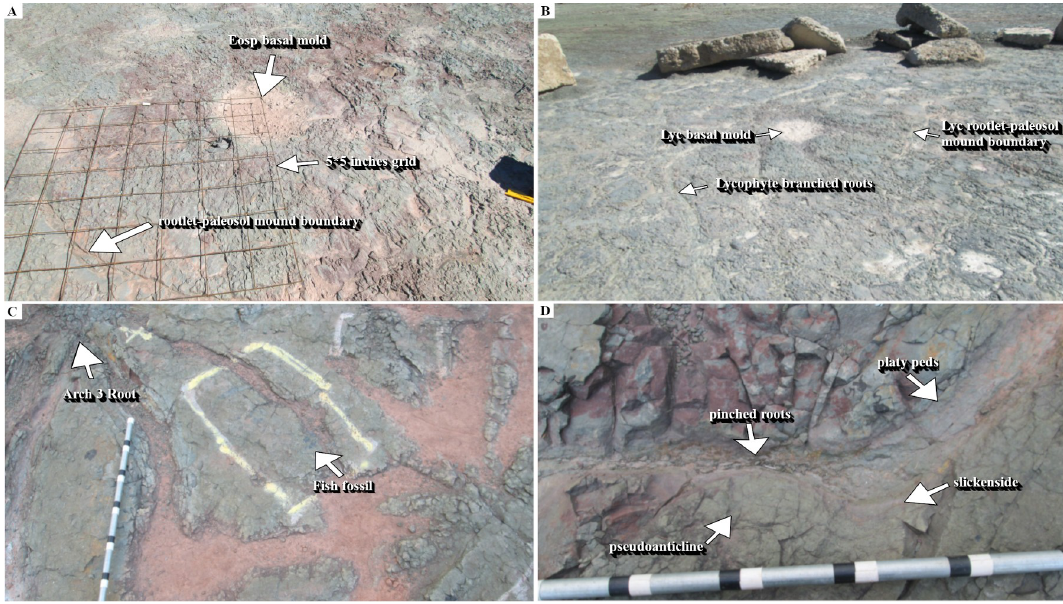
Fig 14. Representative fossils of roots systems belonging to three Middle Devonian tree clades. (A) Eospermatopteris stump-molds composed of a central depression surrounded by a raised mound of paleosol-rootlets. The mound is covered with rootlet rhizohalos. Note the slickensides at the boundary between the paleosol-rootlet mound, and the paleosol-matrix. The grid used to map the rooting system is also visible in the picture. (B) The lycopsid root system was composed of Eospermatopteris- like stump mold and Archaeopteris -like branched roots. (C) Proximal roots of Arch-3 and a trapped fossil of fish that was marked with yellow color for the extraction. (D) A pinched root of Archaeopteris between pseudoanticlines. The slickensides and platy peds that developed around the root are notable features of root-paleosol